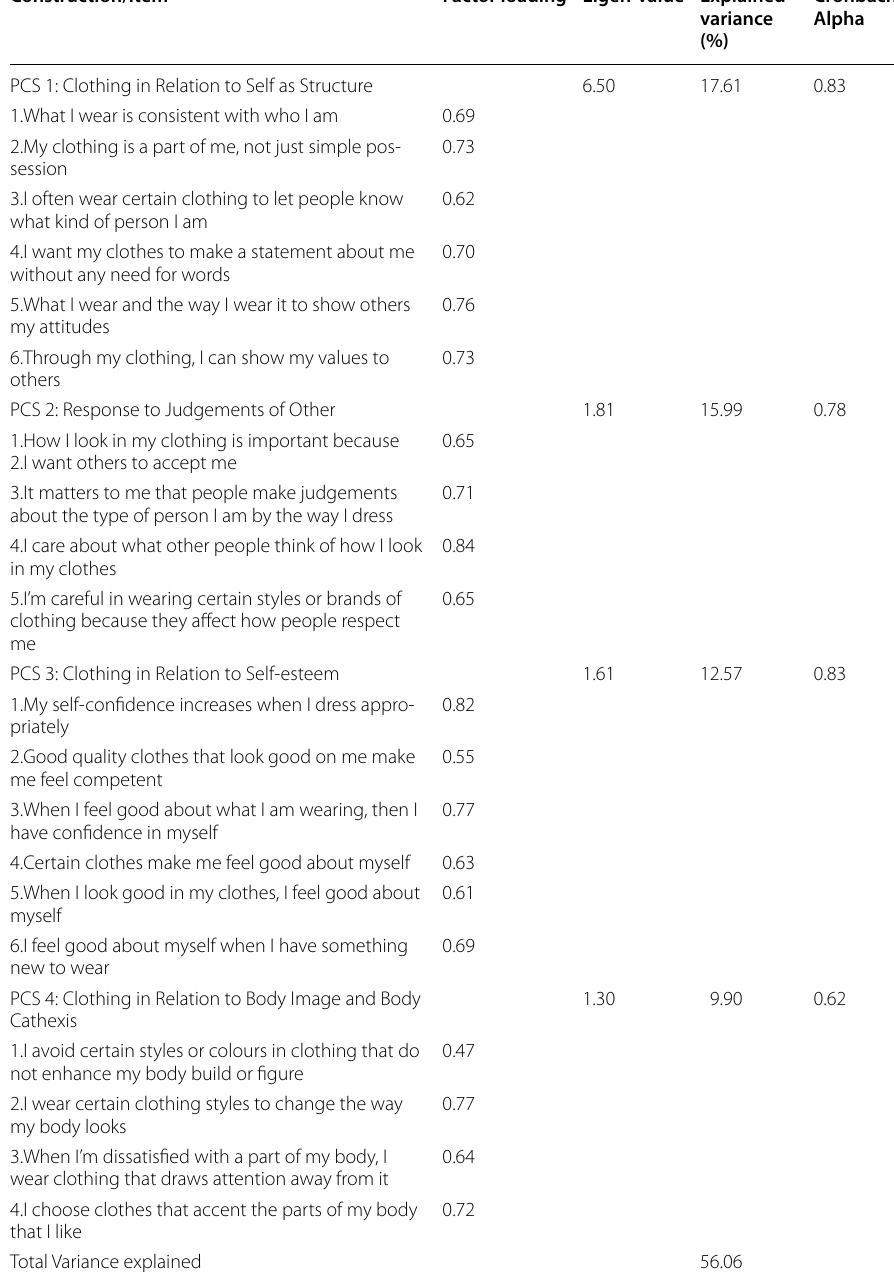
Table 2 Factor analysis results for PCS Construction/item Factor loading Eigen-value Explained